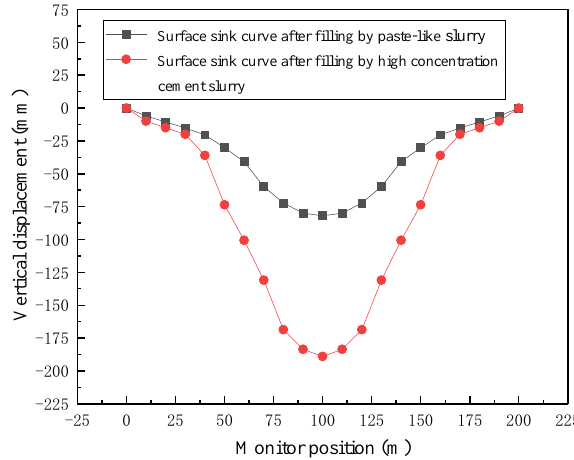
Figure 18. Surface sink curves of two filling slurries at the same filling rate.